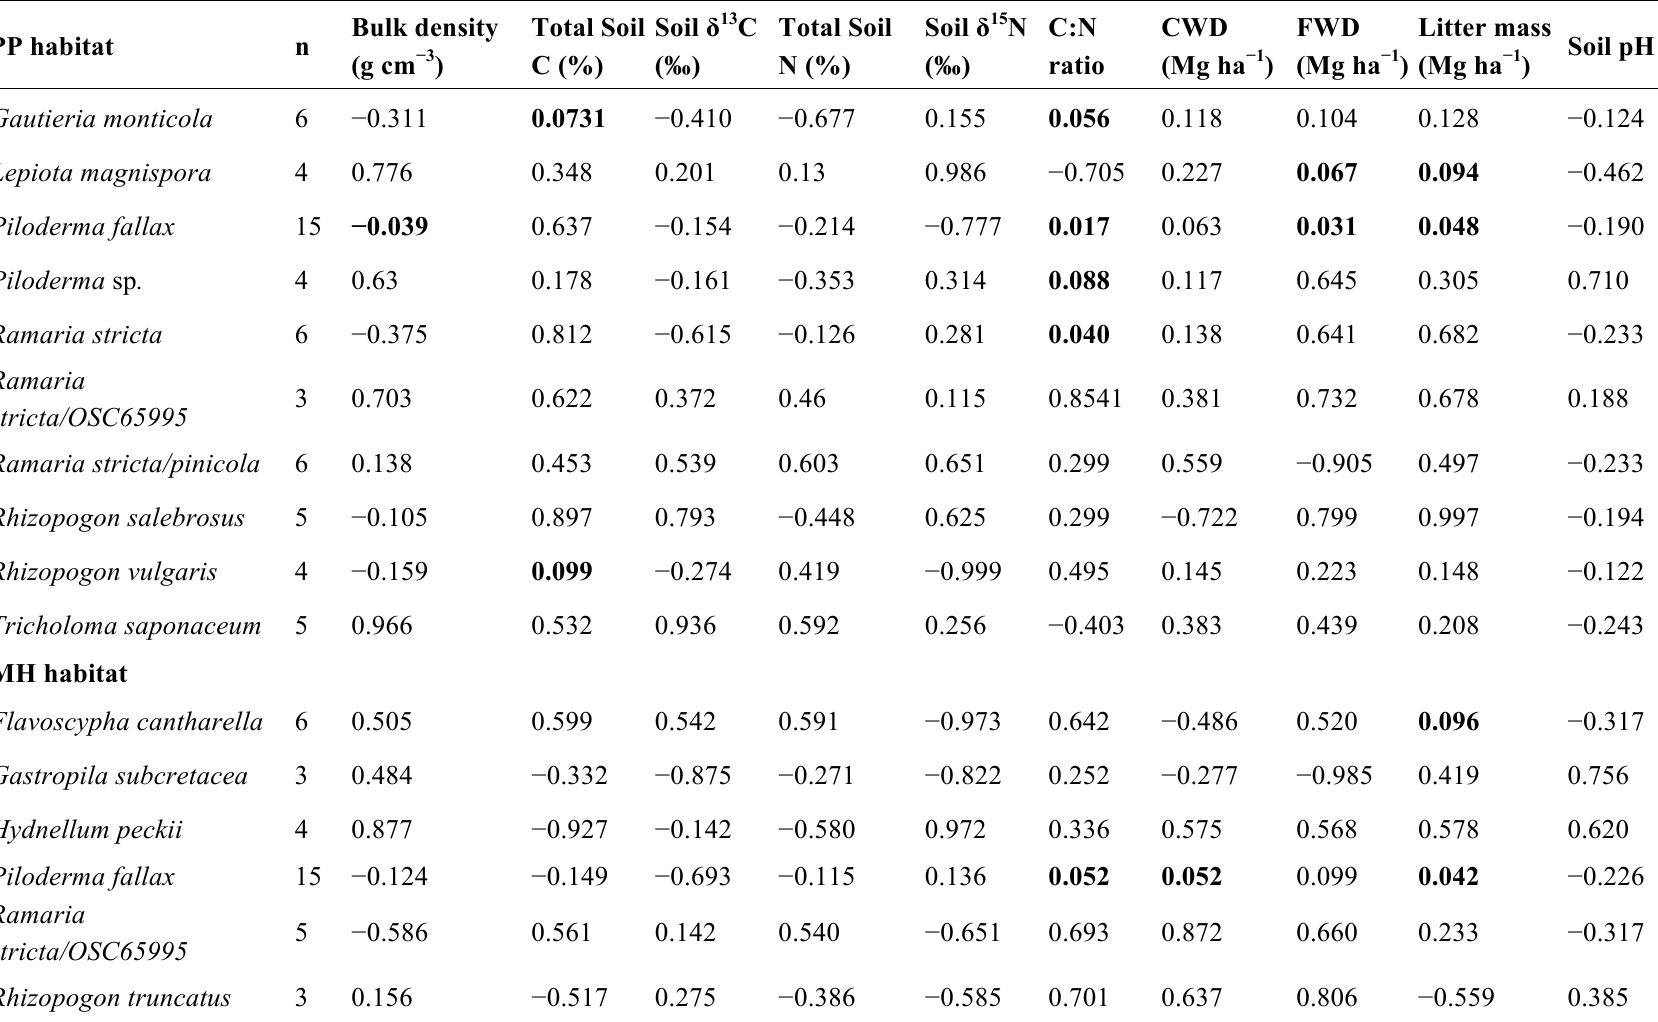
Table 4. P values of logistic regression of habitat associations on those taxa collected at least 3 times within a habitat type. A negative sign indicates a negative correlation; values significant at α < 0.1 are bolded. PP = ponderosa pine habitat, MH = mountain hemlock habitat, CWD = coarse woody debris, FWD = fine woody